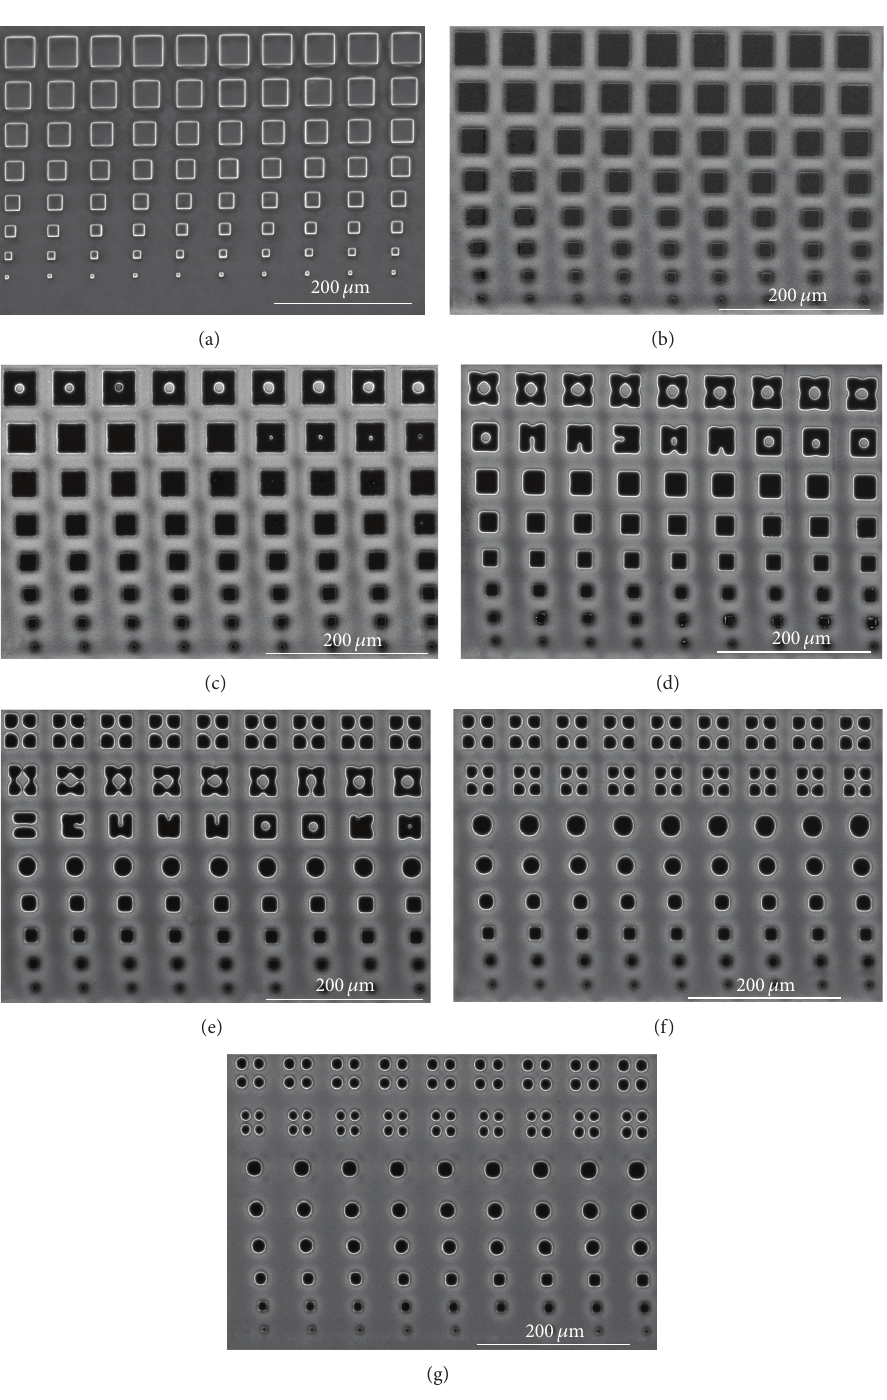
Figure 5: SEM images of the template with square patterns and structures formed in EHD patterning. (a) The template with square patterns, (b) the structures obtained in experiment with 3.0 𝜇 m spacer height, (c) with 3.2 𝜇 m spacer height, (d) with 3.4 𝜇 m spacer height, (e) with 3.6 𝜇 m spacer height, (f) with 3.8 𝜇 m spacer height, and (g) with 4.0 𝜇 m spacer